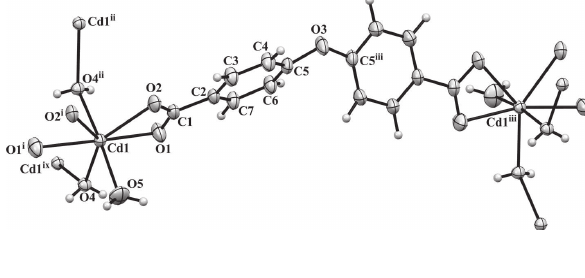
Table 1: Data collection and handling.